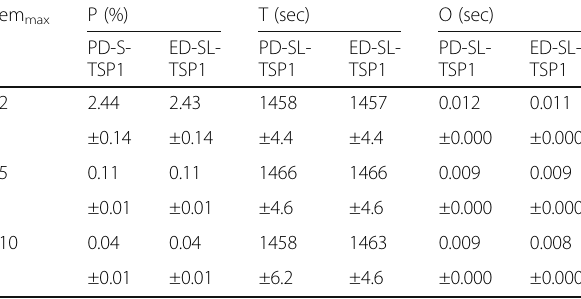
Table 6 LIGO workload: effect of em max on P , T , and O